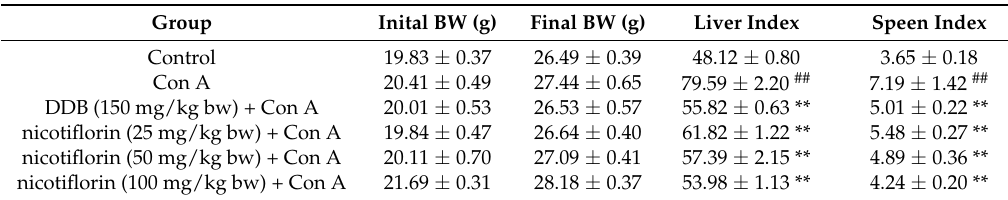
Values are mean ± S.E.M., n = 10; ## p < 0.01 compared with control group; ** p < 0.01 compared with Con A group; BW, body weight.